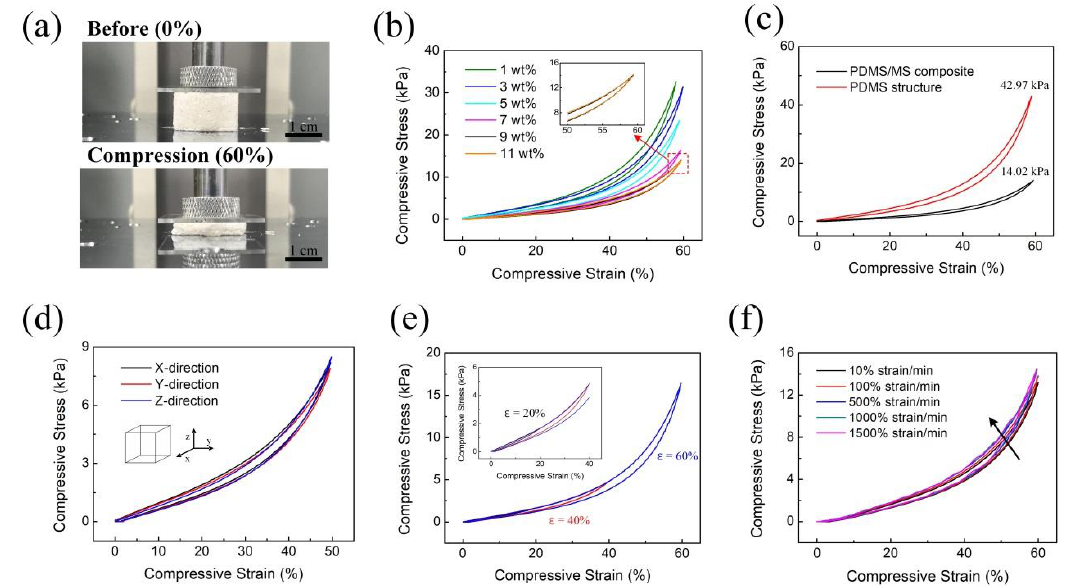
Figure 3. Mechanical evaluation of the PDMS/MS composite. ( a ) The compressive schematic of PDMS/MS composite at 60% strain. ( b ) The measured compressive stress – strain curves according to the concentration of PDMS/MS composite. The curves of 9 and 11 wt.% almost overlap; hence, the 9 wt.% concentration is selected as the maximization point. ( c ) Comparison of compression characteristics of bare PDMS structure and PDMS/MS composite at 60% strain. ( d ) The evaluated compressive stress – strain curves with change in compression direction (x, y, z-direction) for investigating the uniformity of MS. ( e ) The stress – strain curves of PDMS/MS composite with different set strains. ( f ) Stress – strain curves tested under different strain rates.